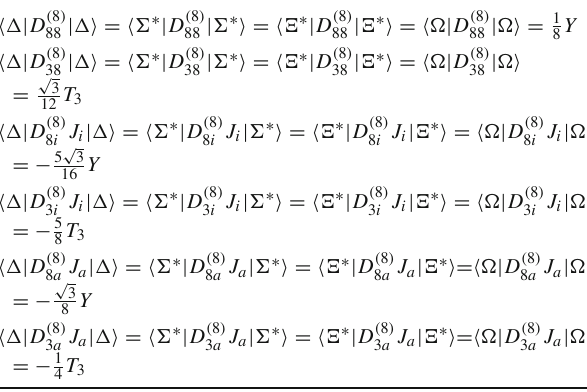
Table 5 The matrix elements of the collective operators of the leading terms and the 1 / N c rotational corrections to the electric monopole form factors